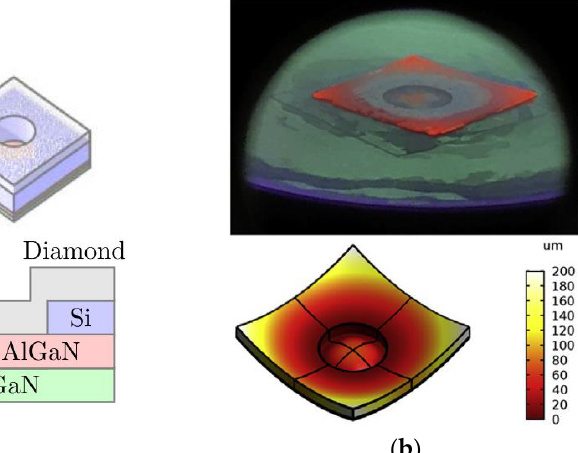
Figure 20. Fabrication of GaN-on-diamond wafers by dual-sided diamond deposition.